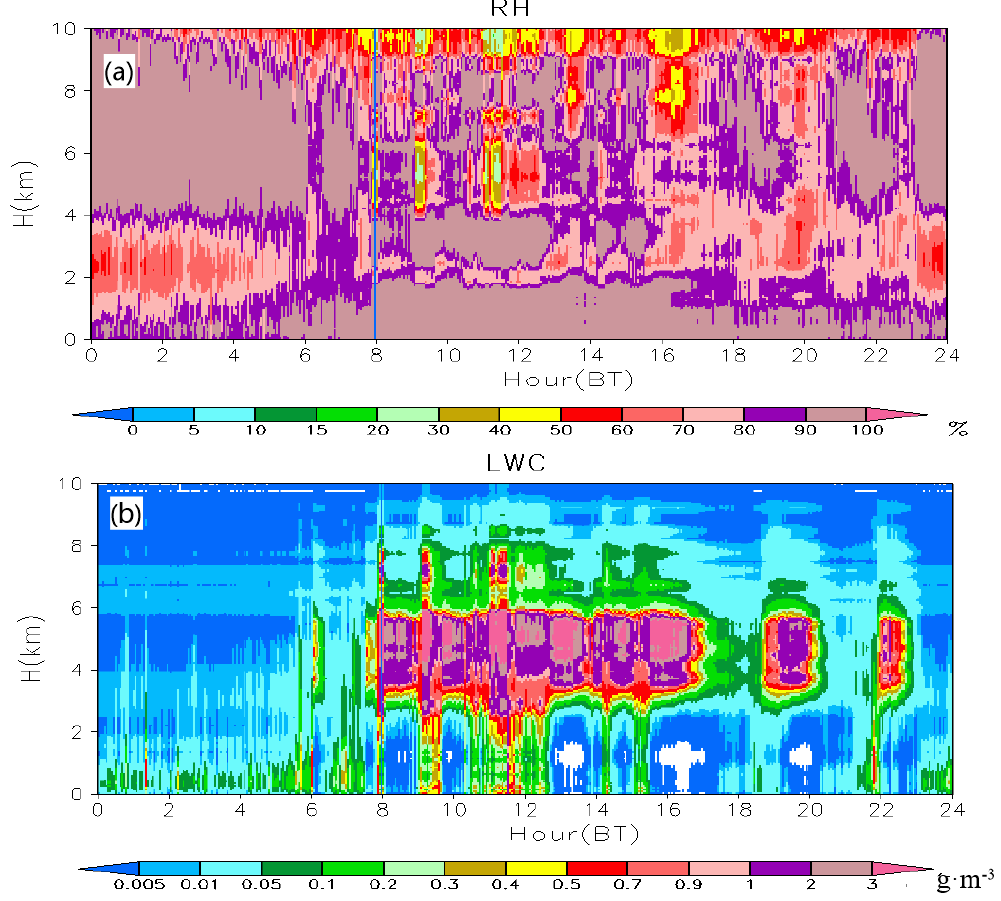
Figure 4. The time-height cross-sections of ( a ) relative humidity (RH) and ( b ) liquid water content (LWC) from MWR data taken on 4 June 2016.